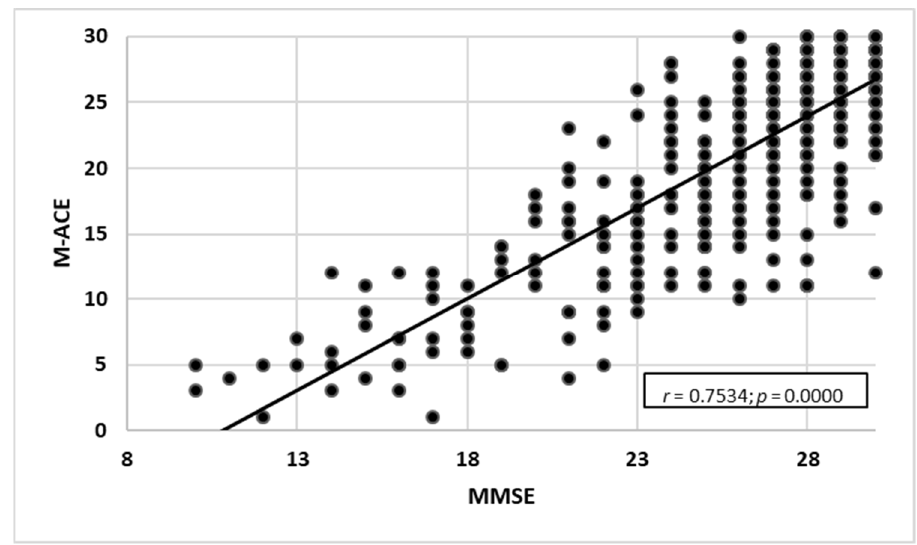
Figure 7. MMSE test results correlated with ACE-III test results ( n = 386).